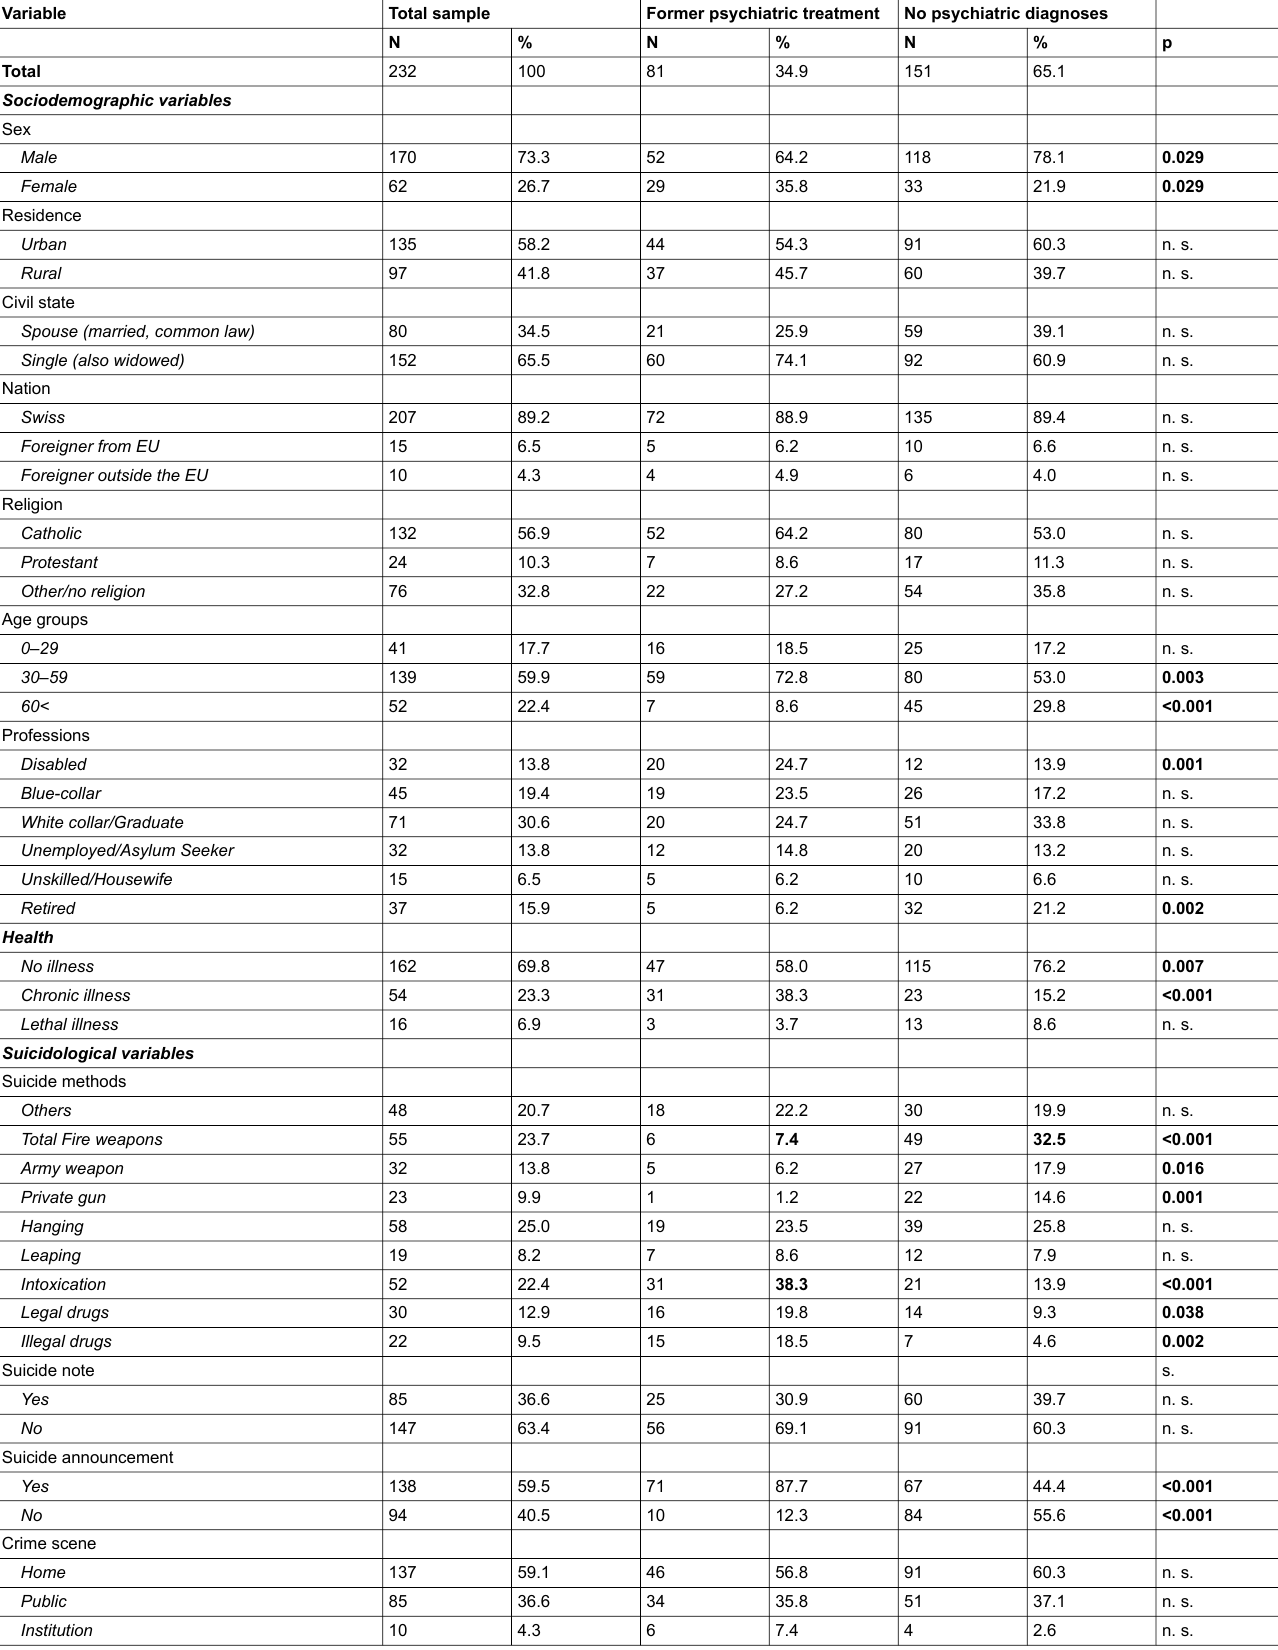
Table 1: Group differences between suicides with and without an established psychiatric